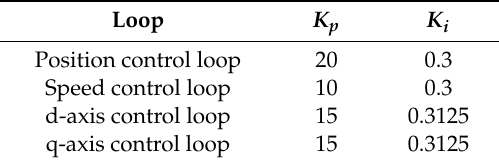
Table 3. The parameters of the proposed controller.